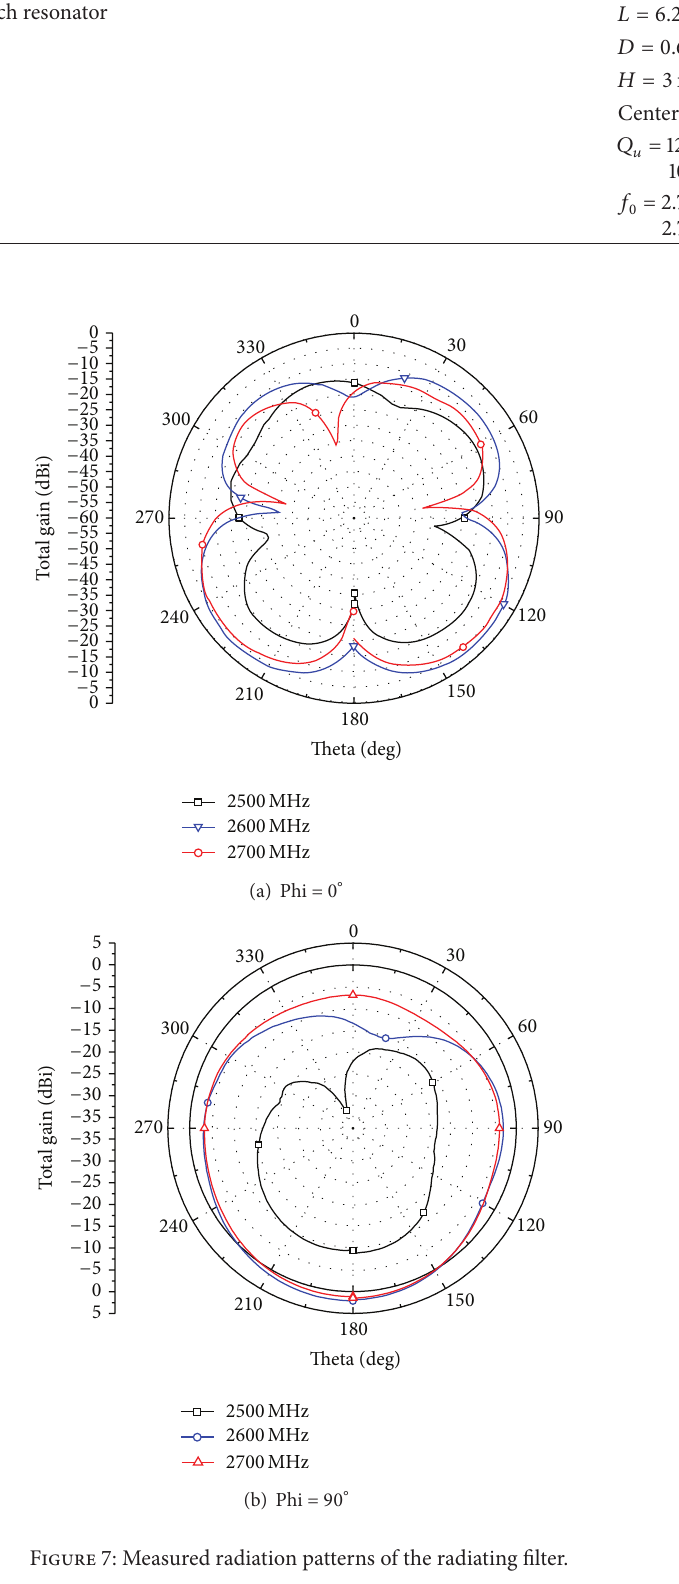
Figure 7: Measured radiation patterns of the radiating